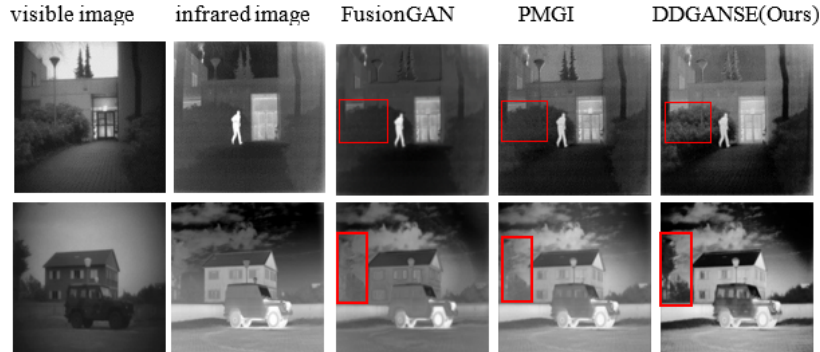
Figure 6. Comparison of texture details in the experimental results. From left to right: visible images, infrared images, and fused results obtained with fusionGAN, PMGI, and DDGANSE (ours).